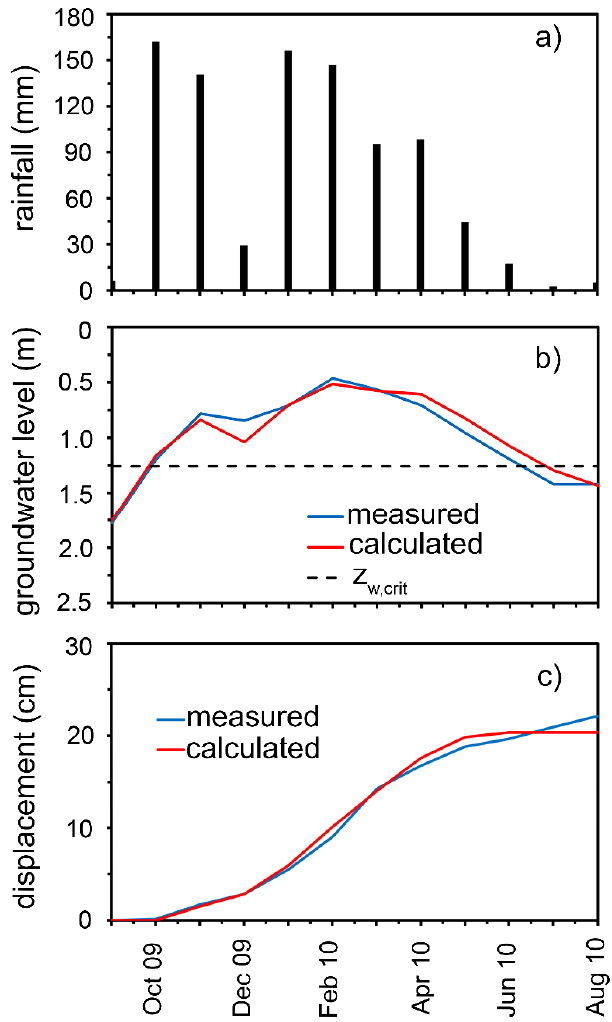
Figure 8. Comparison between observed and calculated results: ( a ) rain recordings, ( b ) groundwater level fluctuations with the indication of its critical position, ( c ) soil displacement in the horizontal direction. All data refer to the period from September 2009 to August 2010.